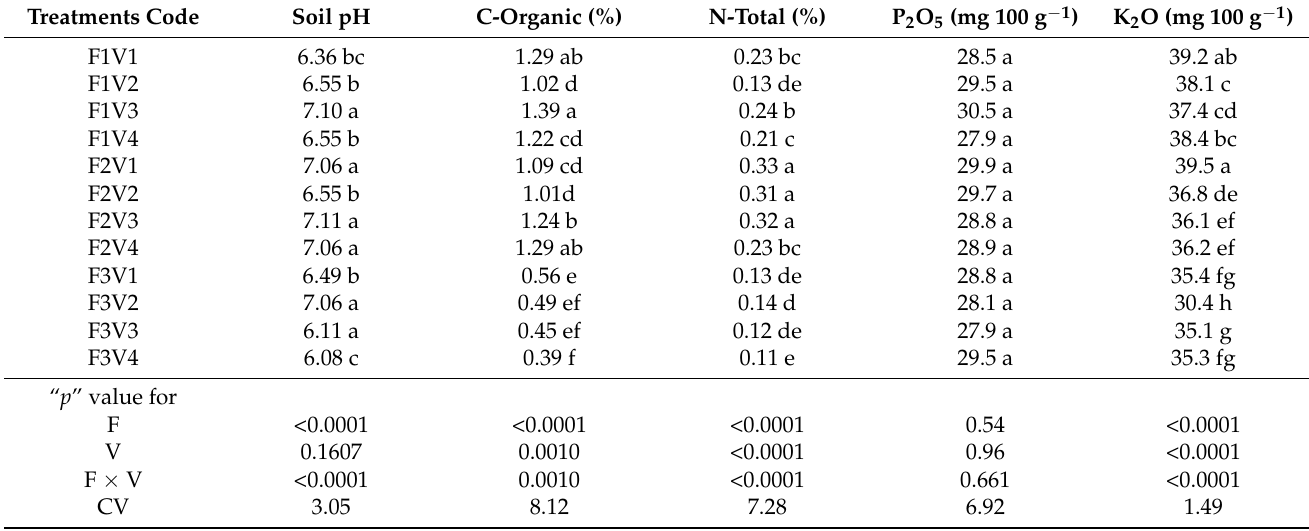
Table 3. Soil properties after trial at research site, Gunungkidul, Yogyakarta, WS 2019/2020. Treatments Code Soil pH C-Organic